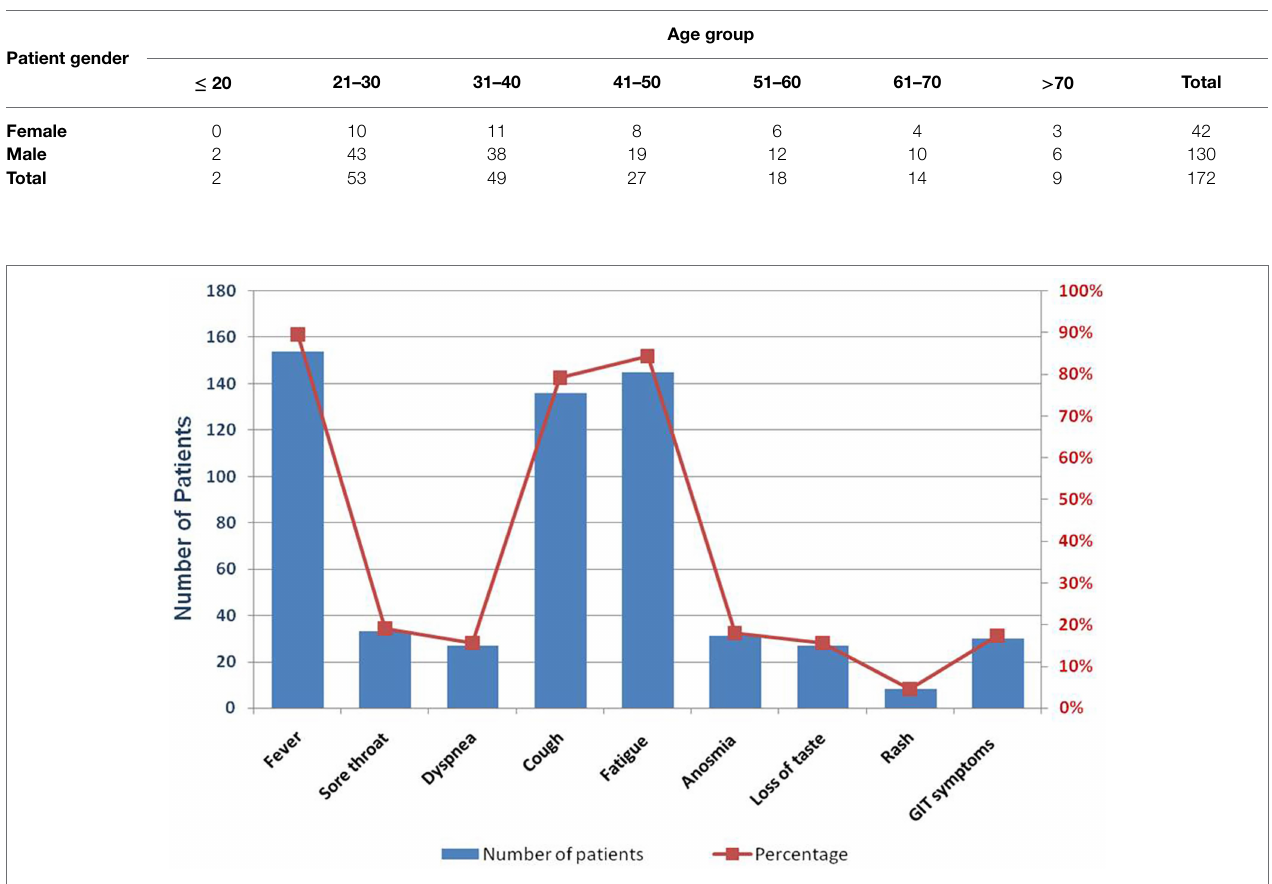
TABLE 1 | The distribution of female and male patients among various age groups.